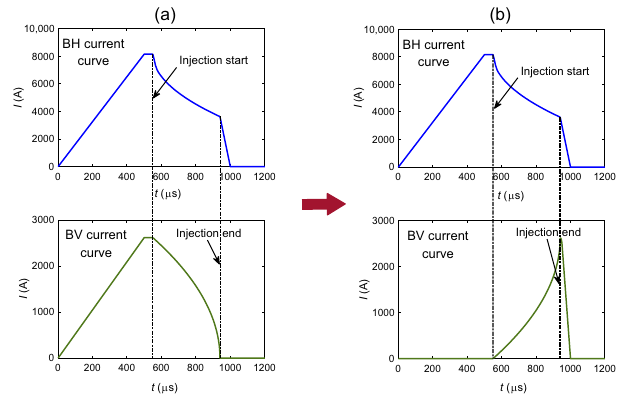
FIG. 6. BH and BV pulse current curves for the anticorrelated painting (a) and correlated painting